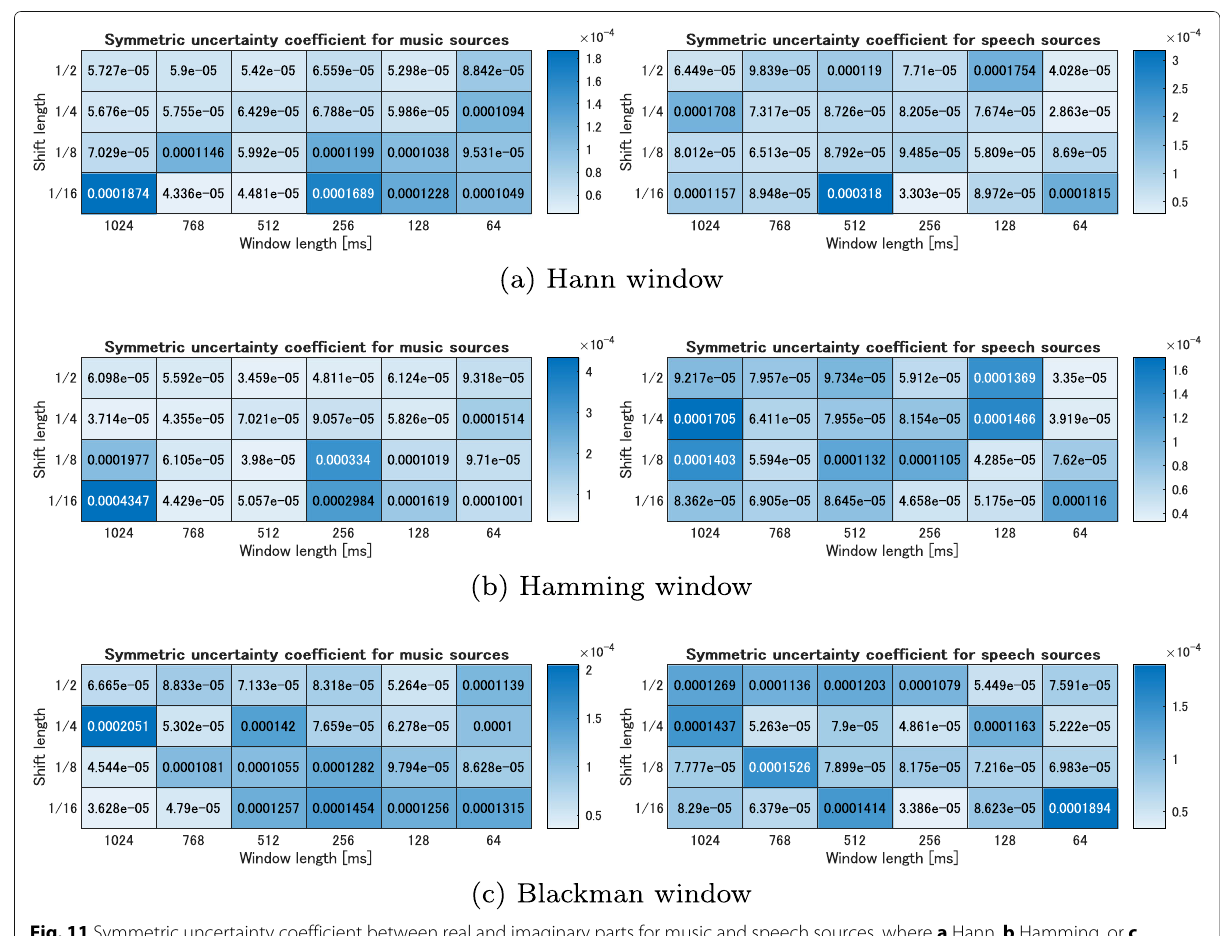
Fig. 11 Symmetric uncertainty coefficient between real and imaginary parts for music and speech sources, where a Hann, b Hamming, or c Blackman window is used in STFT. Left and right columns correspond to the music sources and speech sources, respectively